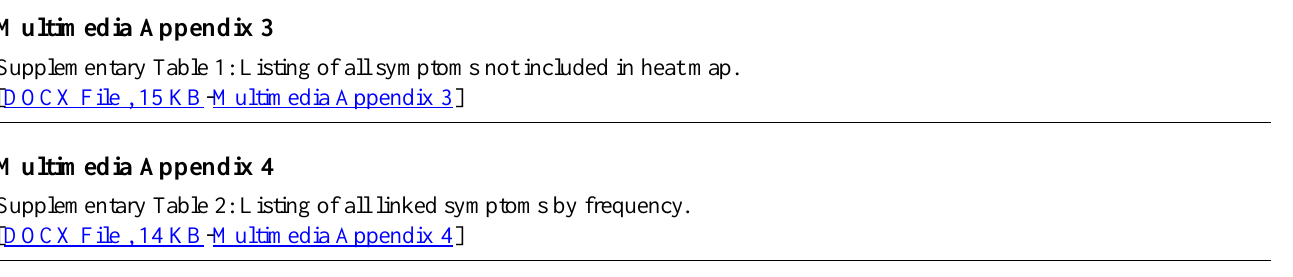
Supplementary Figure 2: Heat map of disorders less frequently reported in forums along with their associated systems. The total number of posts for each disorder is shown on a log scale.